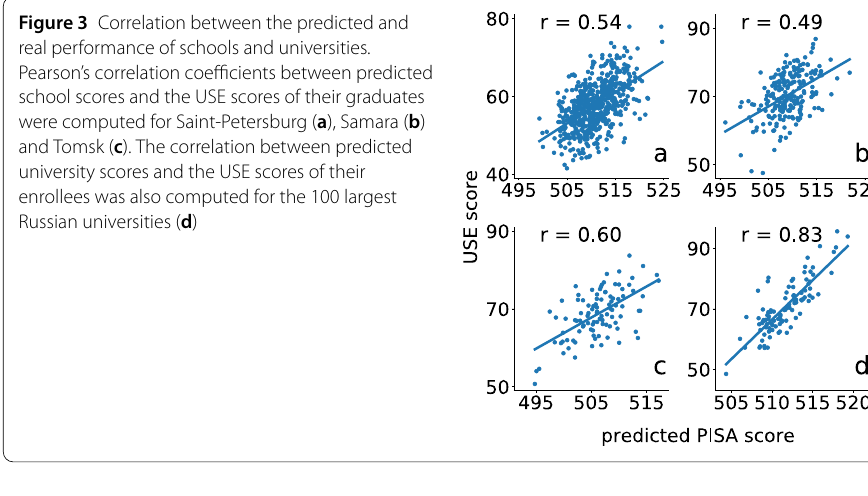
Figure 4 Comparison of predictions based on VK and Twitter data. While estimates from Twitter and VK vary for individual universities the overall performance of the model is similar for both cases. Note that the performance of the model is rather low due to the limited number of users per university for whom both VK and Twitter data is